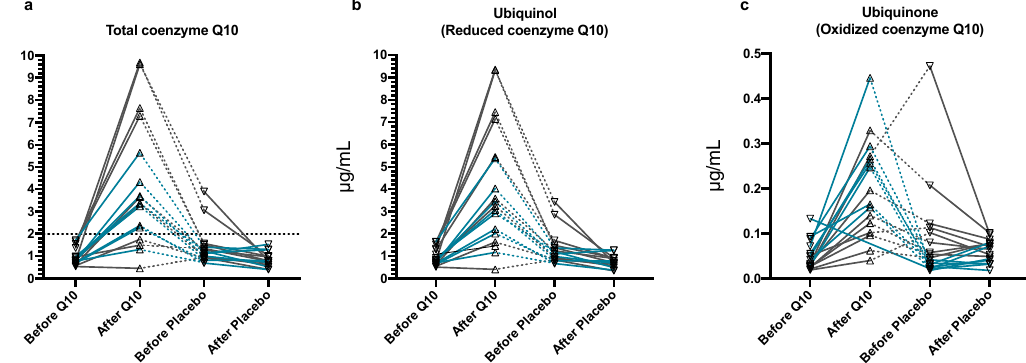
Figure 2. Plasma concentrations of ( a ) total Q10, ( b ) ubiquinone, and ( c ) ubiquinol before and after treatment with Q10 and placebo. Black lines denote dogs treated with Q10 first, then placebo. Blue lines denote dogs treated with a placebo first, then Q10. Dotted lines indicate the washout period. The vertical line indicates a cut-o ff of 2.0 µ g / mL total Q10 in plasma that was the primary endpoint